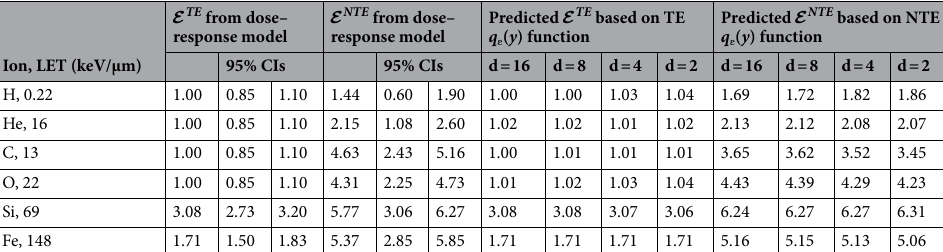
TE NTE Table 3. Low dose TE and NTE metrics, E and E for the six radiation types. Comparison of these metrics derived from fitting the dose–response model to the measured data (Table 1) vs. corresponding predictions based on d ( y ) and best-fit q ɛ ( y ) functions (Table 2). Predictions are shown for each spherical target diameter (d, in µm). Details of the methods are described in the text.